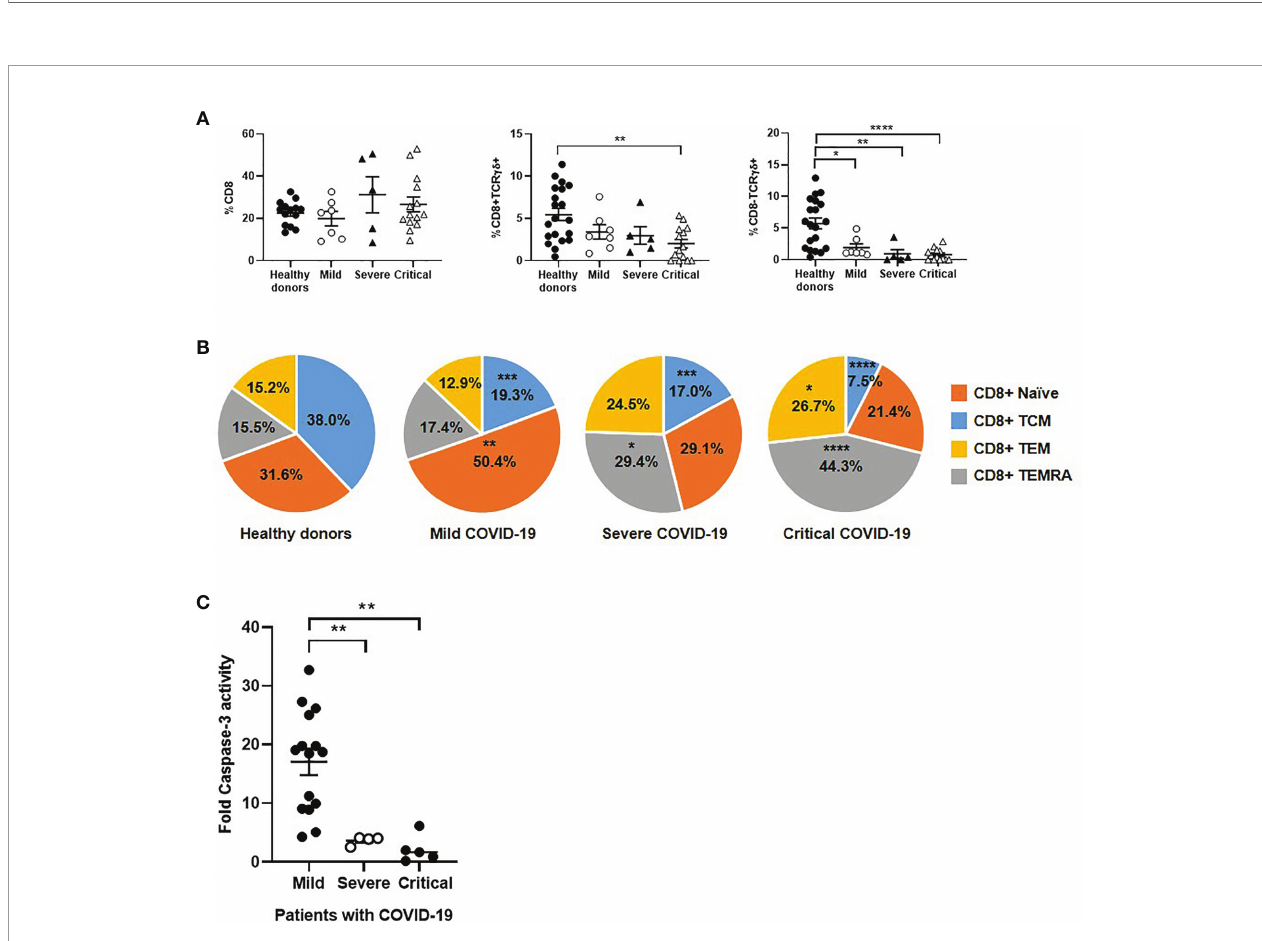
FIGURE 3 | Analysis of CD8+ T cell subpopulations in patients with different stages of COVID-19. The levels of classical CD8+ T cells and unconventional CD8 ± TCR gd + (A) , as well as the distribution of CD8 subpopulations (B) , were analyzed in PBMCs of patients with mild, severe and critical COVID-19, in comparison with healthy donors. (C) Antiviral cytotoxicity of PBMCs from patients with different presentations of COVID-19 was analyzed by quantifying caspase-3 activity in a monolayer of Vero E6 cells infected with pseudotyped SARS-CoV-2 viruses D614 and G614 that were co-cultured with PBMCs (1:10) for 1 hour. Each dot corresponds to one sample and lines represent mean ± SEM. Statistical signi fi cance was calculated using one-way ANOVA and Tukey ’ s multiple comparisons test. *p < 0.05; **p < 0.01; ***p < 0.005; ****p <